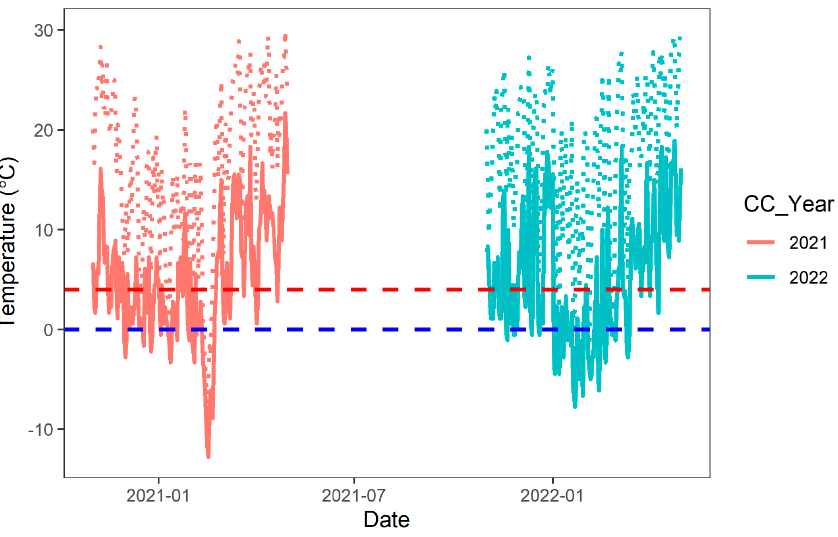
Figure 2. Temperature during 2021 and 2022 cover crop cycles. Solid lines are minimum temperature while dotted lines are maximum temperature. Two dashed lines represent frost period initiation (blue dashed line, 0 ◦ C) and second growing degree day base temperature (red dashed line, 4 ◦ C) for winter cover crops.